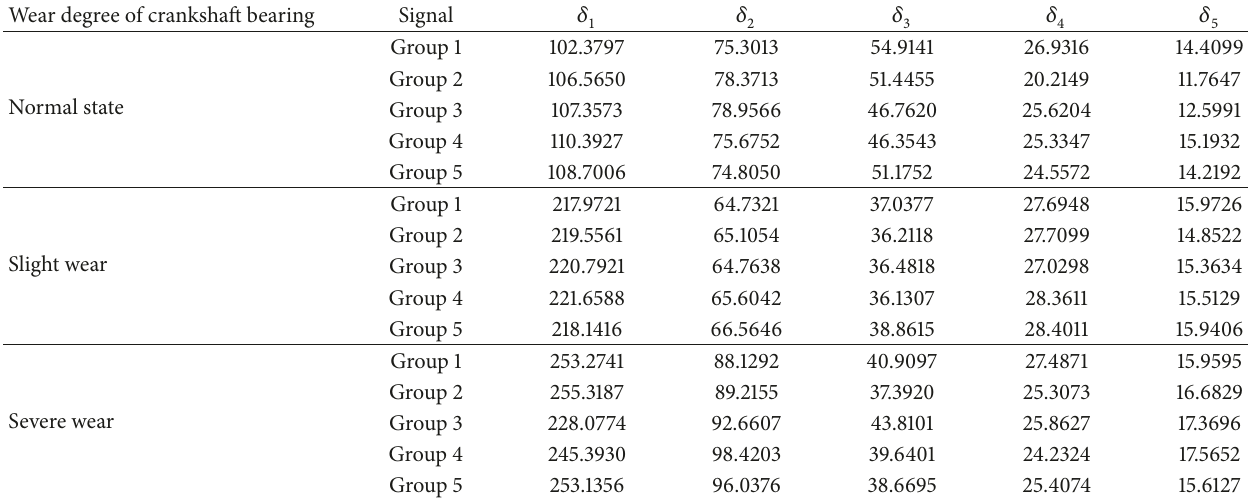
Table 2: Singular value decomposition results of vibration signals in different states of crankshaft bearing.